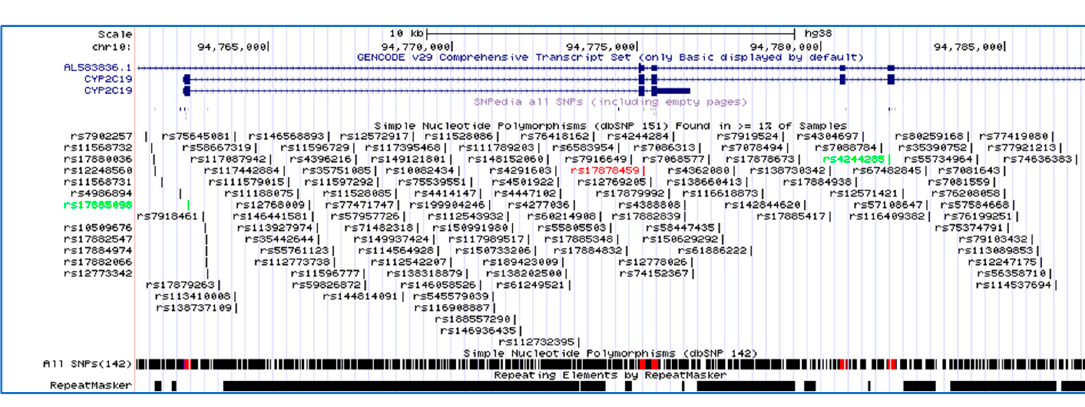
Figure 5. Single nucleotide polymorphisms (SNPs) of the CYP2C19 gene was identified using the University of California, Santa Cruz (UCSC) genome Browser on Human (GRCh37/hg19) assembly from position 94,765,00 to 94,785,00 on chromosome 10.